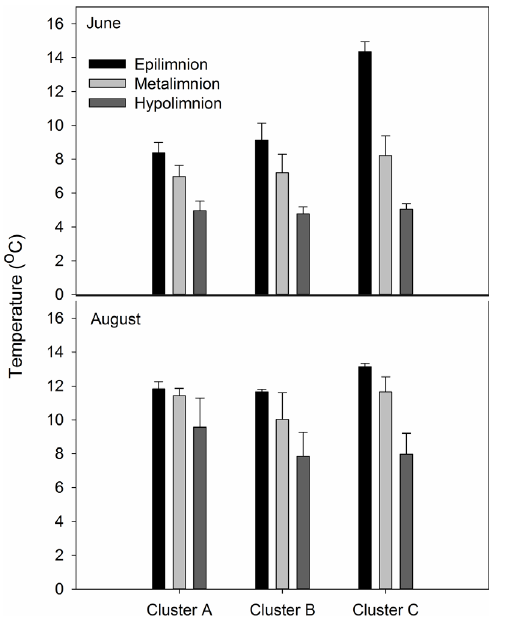
Fig 2. Temperature differences across the ice-free season of summer 2014 in southwest Greenland lakes, including differences in depth and regions. Bars represent 1 SE of the mean. Statistics outlining differences among groups may be found in the